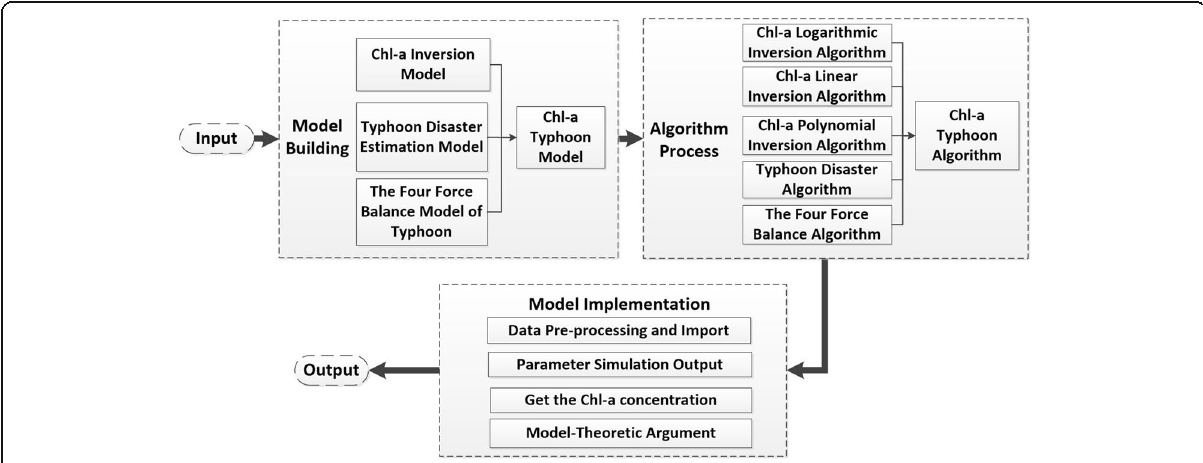
Fig. 1 The framework of typhoon disaster model